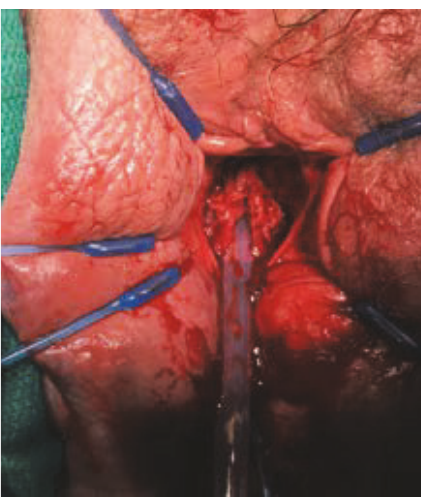
Figure 3: The third layer of the bladder neck closure can be appreciated. The cadaveric pericardial tissue in place to prevent vesicovaginal fistula formation.